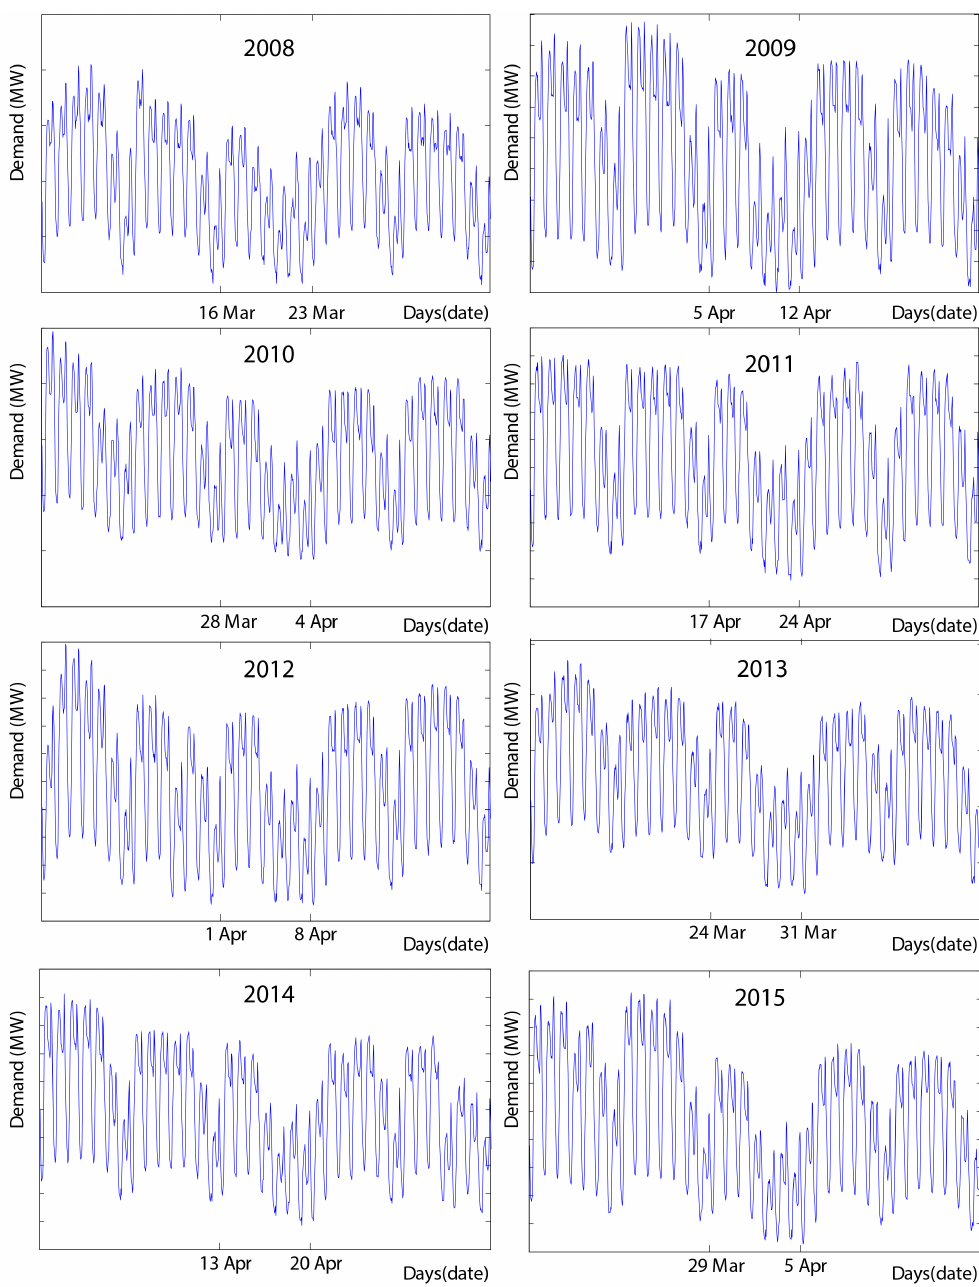
Figure 3. Hourly electricity demand in Spain in the weeks around Easter. It can be seen that the dates of Easter vary every year and that a decrease in consumption always takes place during the Easter week. Furthermore, this descent has a similar behaviour every year.